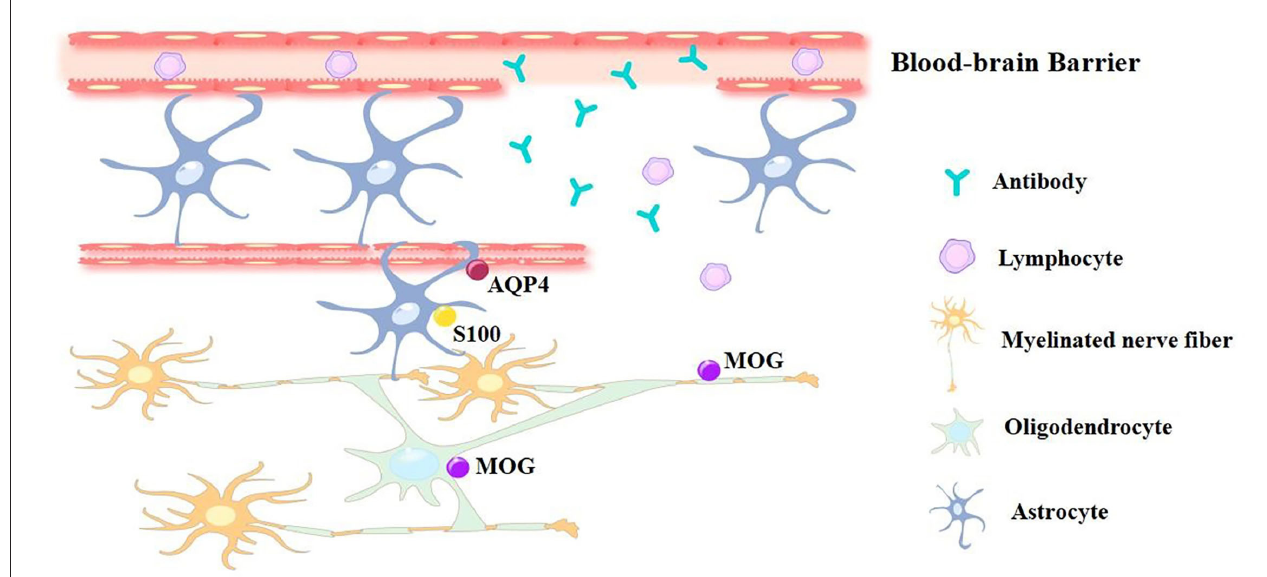
FIGURE 1 | The pathological effect caused by blood-brain barrier damage. The blood-brain barrier damage during AE progress is caused by Th17 cell activation, this leads to antibodies and lymphocytes entering the brain and cerebra-spinal fluid. Traditional methods for AE diagnosis are using CFS to detect relevant positive Ab, while novel approach to diagnose AE are using potential biomarkers, including cytokines/chemokines and molecules like MOG, AQP4 and S100 protein that expressed on nerve